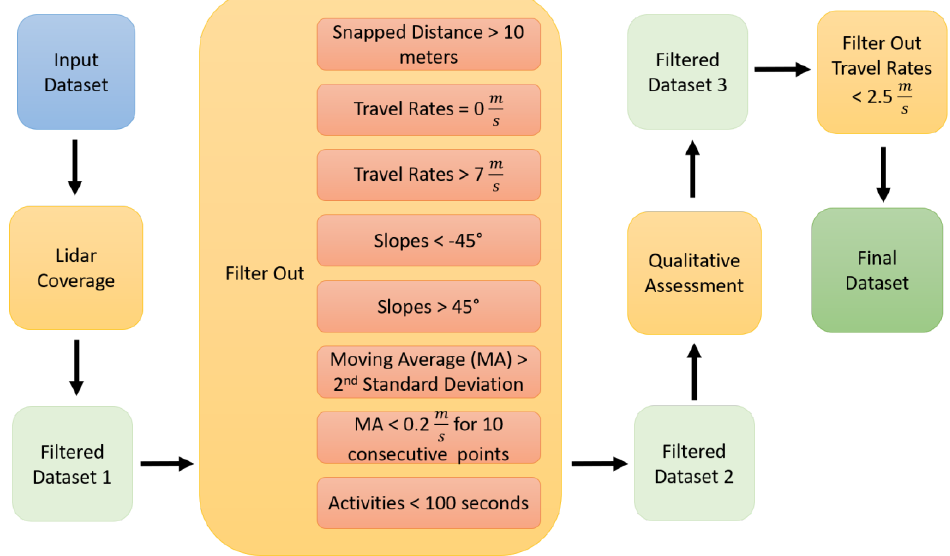
Figure 2. Flowchart visualizing the data filtering processes. The blue square represents the input data, orange rectangles show processes, light green squares represent intermediate datasets, and the dark green square represents the final dataset.